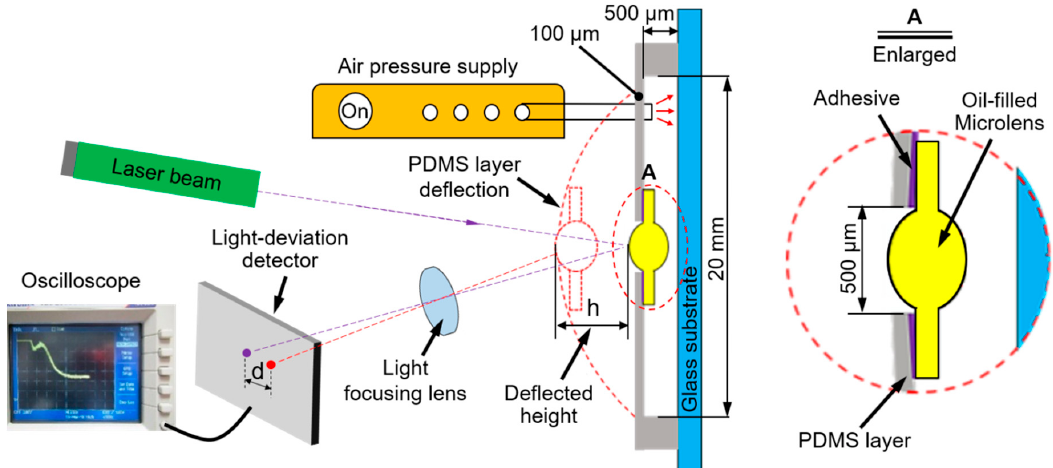
Figure 3. Illustration of the PDMS chamber inflation measurement experimental setup. The PDMS layer deflections h were detected by the laser beam displacement distance d that was recorded with an oscilloscope. Enlarge image A illustrates the attaching structure of the microlens to the PDMS layer ( this image is not to scale ).